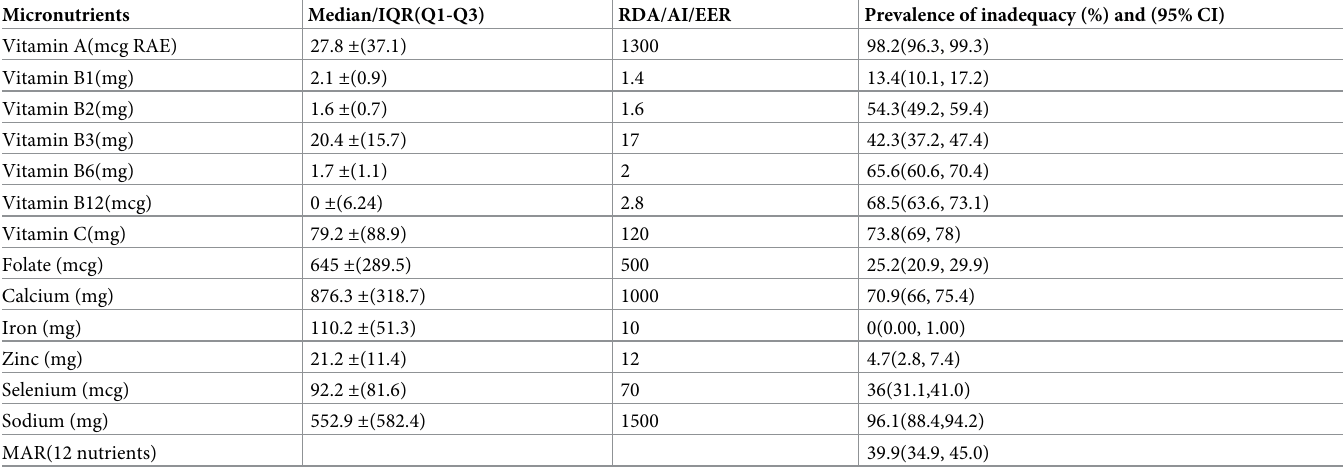
Table 3. Micronutrient intake of lactating women in Bahir Dar city, Northwest Ethiopia, 2021(n = 381).